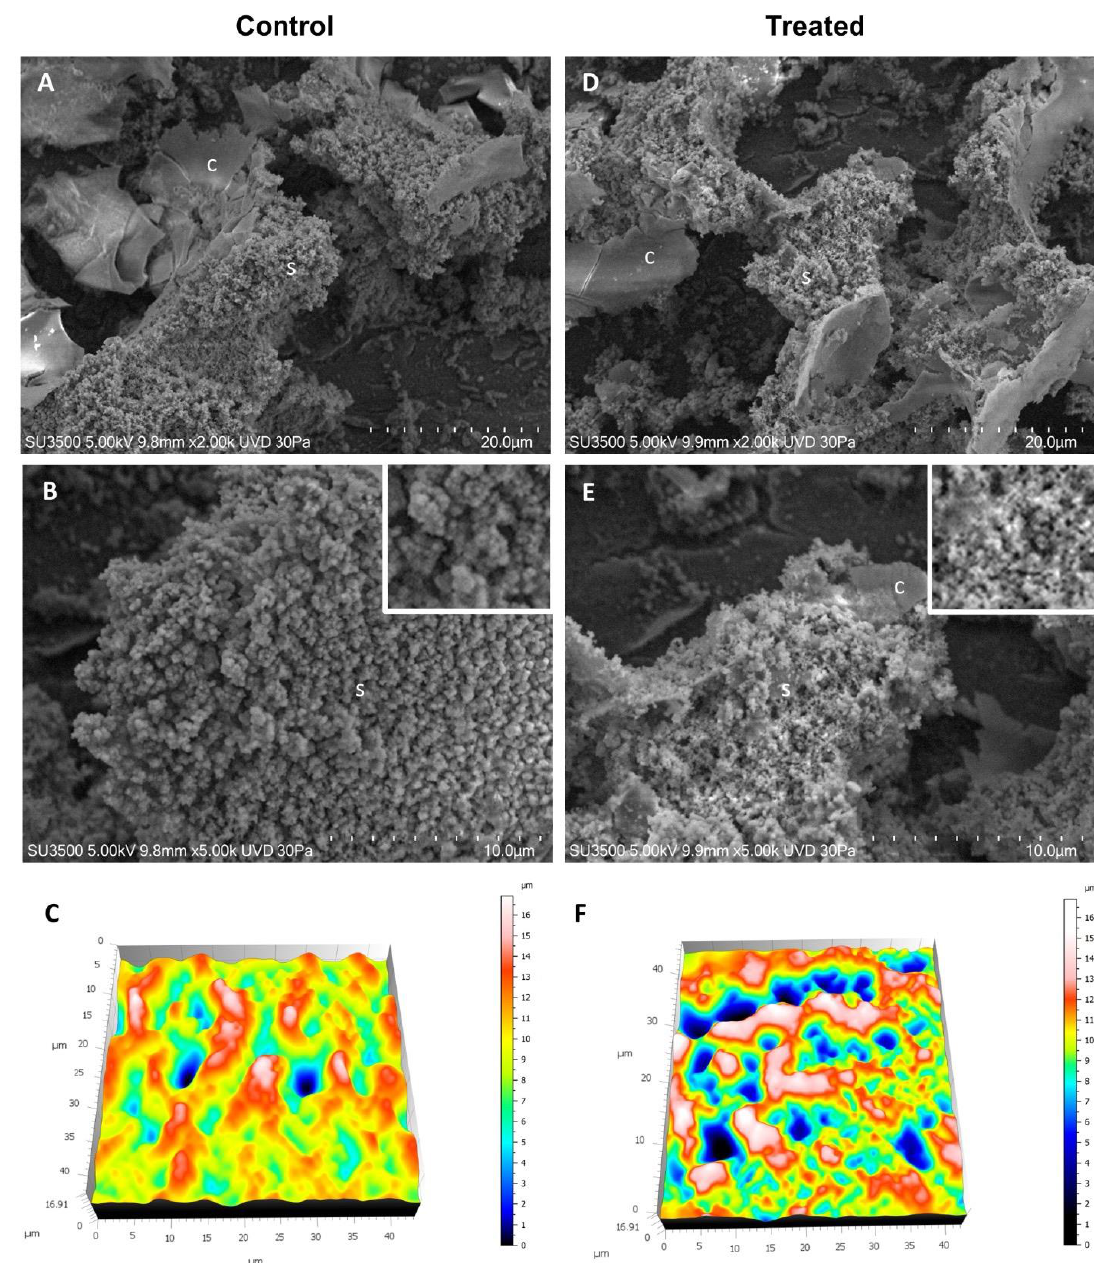
Figure 6. VP-SEM images of E. coli ( A – C ) and E. coli treated with CIP-loaded niosomes ( D – F ). ( A ) Low magnification (2.00K), ECM shows compact and smooth ECM areas (c), as well as spongy and rough areas (c). ( B ) Higher magnification (5.00K) of the ECM spongy area, ECM trabeculae show a globular structure (inset). ( C ) 3D reconstruction of sample surface topography, ECM trabeculae are represented in white and red areas, and the channels that perforate the ECM are represented with color shades from green to blue. ( D ) Low magnification (2.00K), ECM shows both compact and smooth ECM areas (c), both spongy and rough areas. ( E ) Higher magnification (5.00K) of the ECM spongy area, ECM trabeculae show a fine filamentous network structure (inset). ( F ) 3D reconstruction of sample surface topography, ECM trabeculae are represented in white and red areas, and the channels that perforate the ECM are represented with color shades from green to blue. Note that ECM presents more channels than the control, and trabeculae are thinner than the control sample.